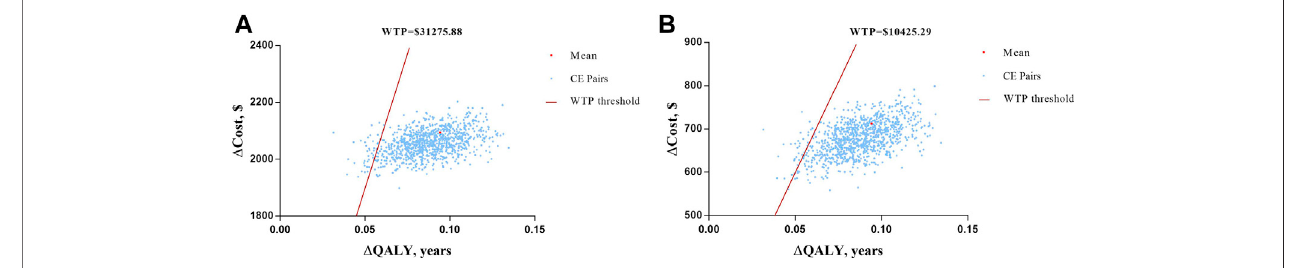
FIGURE4 | Scatter plots ofICUR for the treatment with semaglutidevs. empagli fl ozin. (A) Atthe assumptionof annual cost of semaglutideof$667.04with aWTP threshold value of $10,425.29. (B) At the assumption of annual cost of semaglutide of $877.43 with a WTP threshold value of